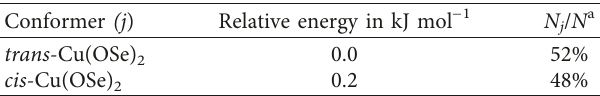
Table 1: The relative energies and populations of the Cu(II)(OSe) complexes investigated.